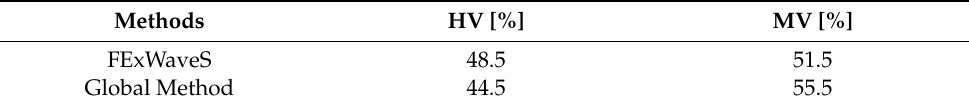
Table 5. Origin assessment: number of events for each label and criterion expressed as a percentage of the total number of